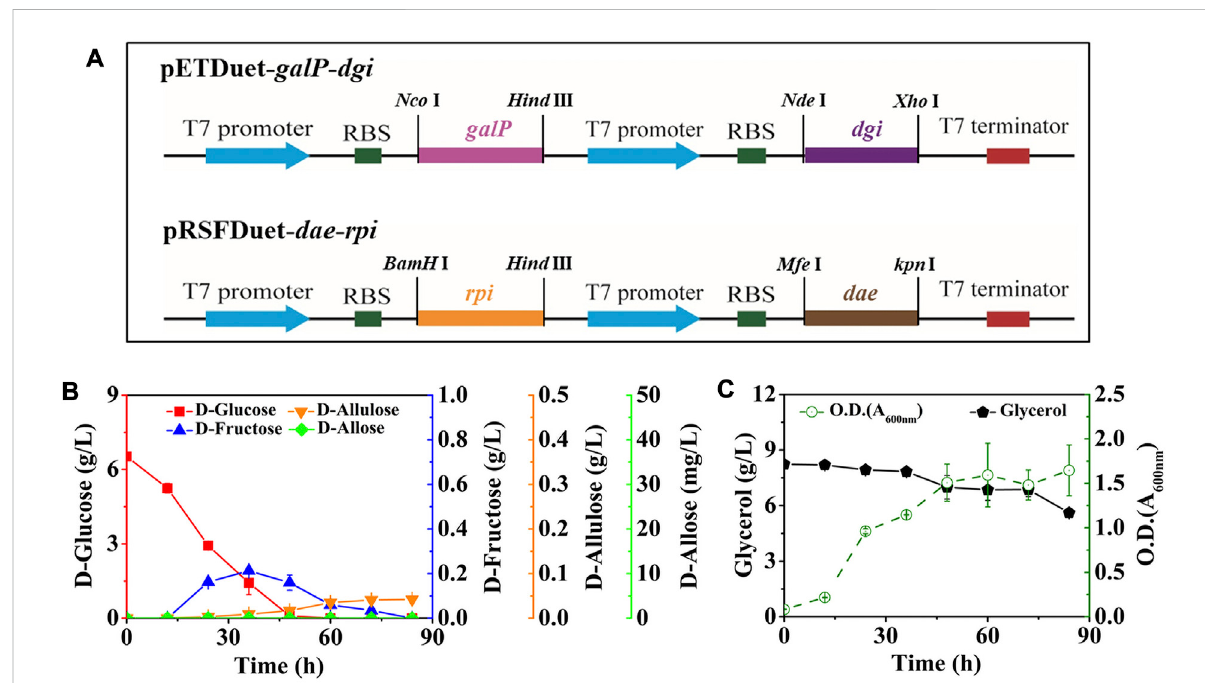
FIGURE 3 SynthesisofD-allosebyfermentationusing E.coli (DGI,DAE,RPI,GalP). E.coli (DGI,DAE,RPI,GalP)wasculturedinM9mediumwithD-glucose and glycerol at 30 ° C. (A) Recombinant plasmids of pETDuet- galP - dgi and pRSFDuet- dae - rpi . (B) D-Glucose, D-fructose, D-allulose, and D-allose. (C) Glycerol and cell density. Error bars indicated standard error ( n =